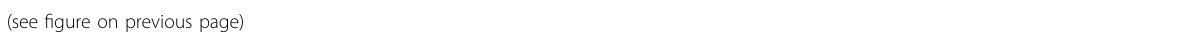
Fig. 2 Delta-secretase enhances AD-like pathologies in hAPP/hMAPT double-transgenic mice. A δ -secretase overexpression induces APP and Tau proteolytic cleavage in the double-transgenic mice. Western blot assays demonstrated δ -secretase-cleaved APP, and Tau fragments promoted AD-like pathologies in human wild-type APP and Tau double-transgenic mice. Arrow indicated full-length AEP (~56 kDa), arrowhead indicated activated (mature) AEP (~37 kDa). WT, hAPP, hMAPT, hAPP/hMAPT mice at the age of 2-3 months old were injected with AAV-AEP virus in the bilateral hippocampus for 3 months. WT mice (lane 1 and 2) and hAPP/hMAPT mice (lane 11 and 12) with AAV-Control virus injection were compared. APP NT (for both mouse and human APP), Tau5 (for both mouse and human Tau), HT7 (for human Tau) antibodies were applied to validate the double-transgenic model. AEP (6E3) antibodies were used to verify the ef fi ciency of AAV-AEP virus injection. B δ -secretase elicits AD-like pathologies in hAPP/hMAPT mice. Immuno fl uorescent staining showed AD-like pathologies in the WT, hAPP, hMAPT, and hAPP/MAPT mice injected with AAV-AEP virus, including amyloid deposition (A β antibody), Tau hyperphosphorylation (AT8 antibody), neuroin fl ammation (Iba1 antibody), and the dendritic reduction in the remained neurons (MAP2). The speci fi c antibodies of AEP-cleaved APP (C586) and Tau (N368) were used for the detection of AEP activation (left, scale bar: 50 μ m). Quantitative analysis the percentage of positive cells. The number of Iba1 + microglia cell bodies was count and then calculated as mean±SEM × 10 3 /mm 3 . (right, Mean±SEM, n = 6 mice for each group, one-way ANOVA with Dunnett ’ s multiple- comparisons test. * as compared to WT mice, # as comparison to hAPP/hMAPT mice). C The formation of amyloid plaques and neuro fi brillary tangle (NFT) in four lines of mice treated with the AAV-AEP virus was shown by co-staining of ThS + A β and ThS + AT8, respectively. Scale bar: 50 μ m. D Quantitative analysis to demonstrate the size of A β + plaque and AT8 + NFT (left, Mean±SEM, n = 6 in each group, one-way ANOVA with Dunnett ’ s multiple-comparisons test, * as compared to WT + AAV-AEP virus, # as comparison to hAPP/hMAPT + AAV-AEP virus) and the proportion (%) of Thio fl avin S positive area (right). (Mean ± SEM, n = 6 in each group, one-way ANOVA with Dunnett ’ s multiple-comparisons test, * as compared to WT + AAV-AEP virus, # as comparison to hAPP/hMAPT + AAV-AEP